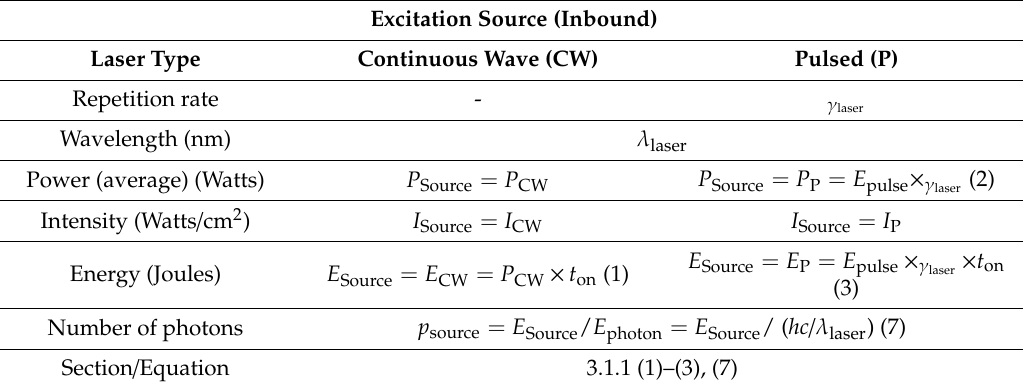
Table 2. Excitation